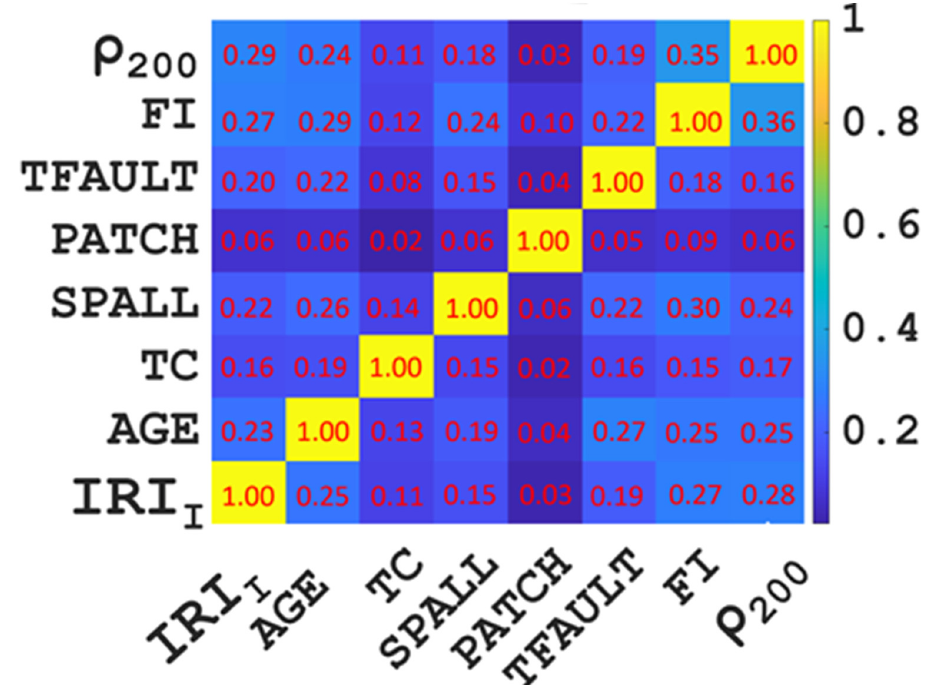
Figure 3. Correlation analysis results of input variables.